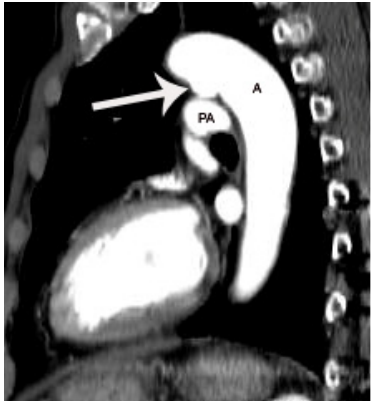
Figure 7. Representative case of a ductus diverticulum in a 60-year-old male, as demonstrated on a sagittal CT image at the level of aortic arch. Although a ductus diverticulum (arrow) may simulate the CT features of conically shaped PDA at the aortic end, it lacks a connection with the left main pulmonary artery.